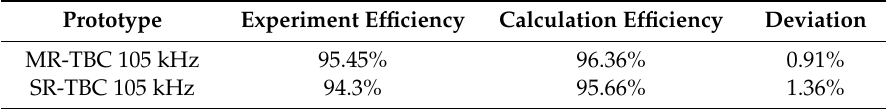
Table 2. Efficiency comparison between MR-TBC and SR-TBC in 1500 W.